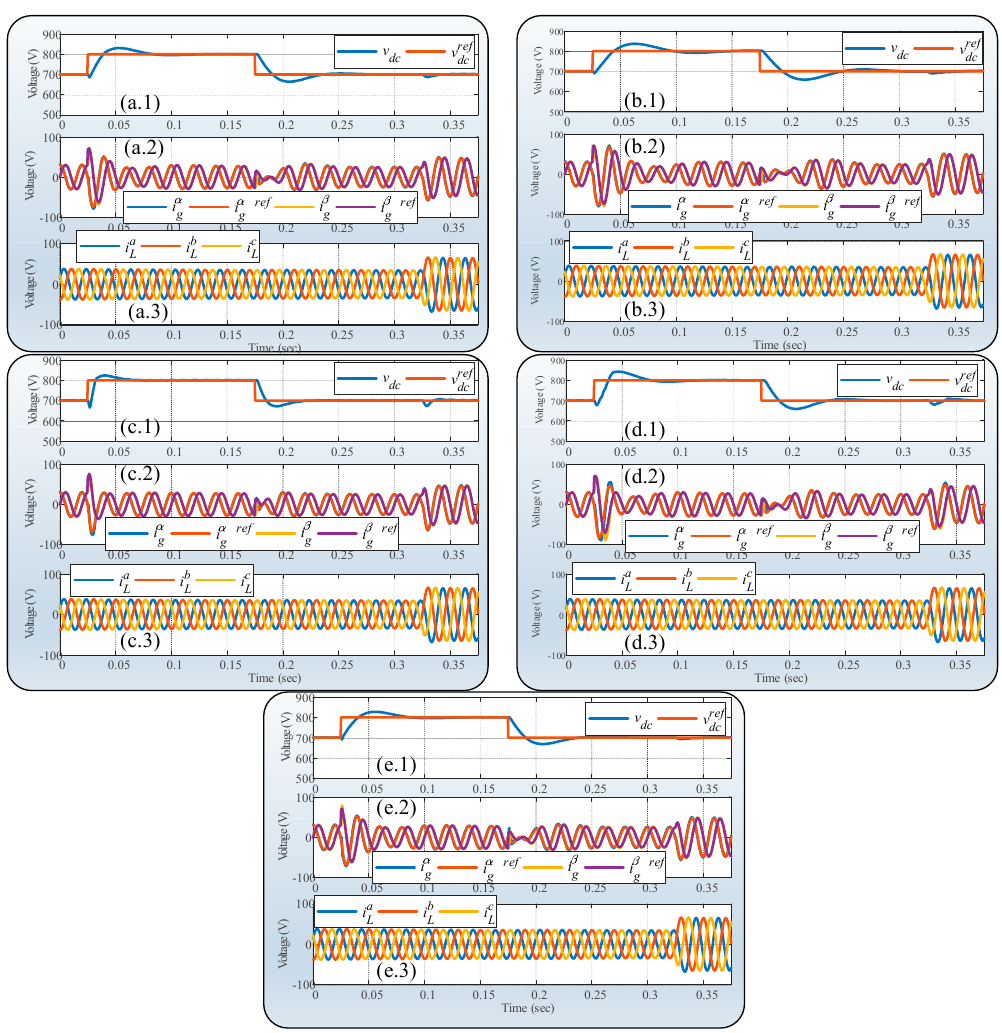
Figure 8. Current and dc voltage control response under parameters variation for N = 24 ( a ) considers parameters listed in Table 1, ( b ) C dc increased a 50%, ( c ) C dc decreased to 50%, ( d ) L g increased a 50%, ( e ) L g decreased to 50% ; for all images ( 1 ) dc voltage control, ( 2 ) αβ current control, ( 3 ) disturbance load abc